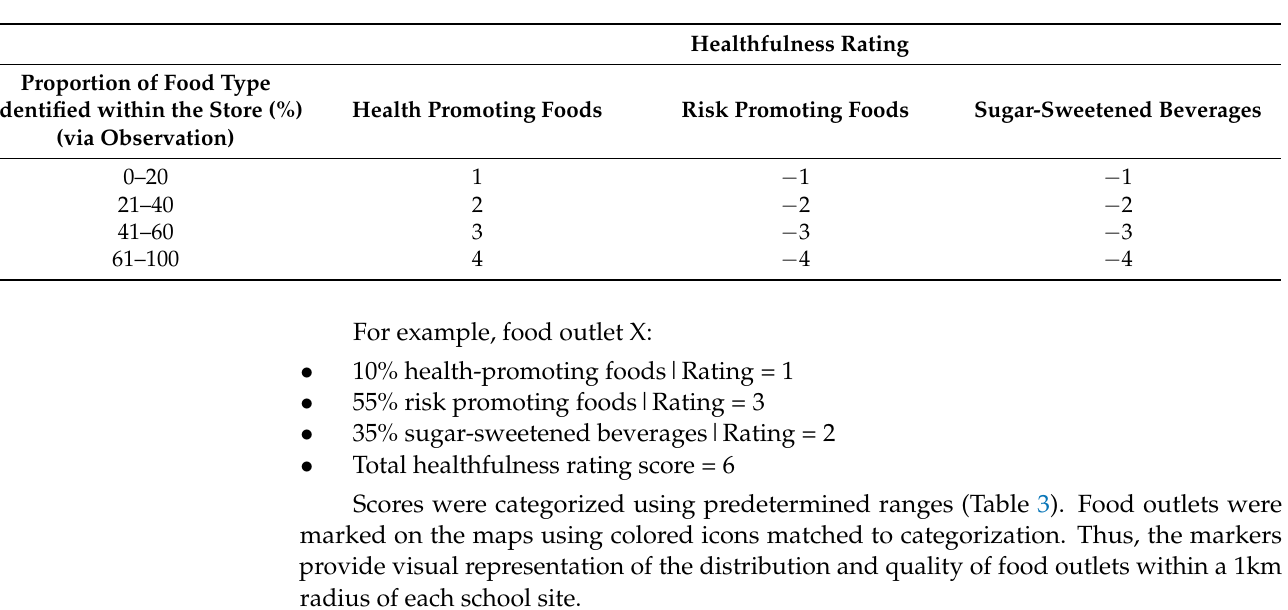
Table 2. Scoring system used for determining the healthfulness rating of a food